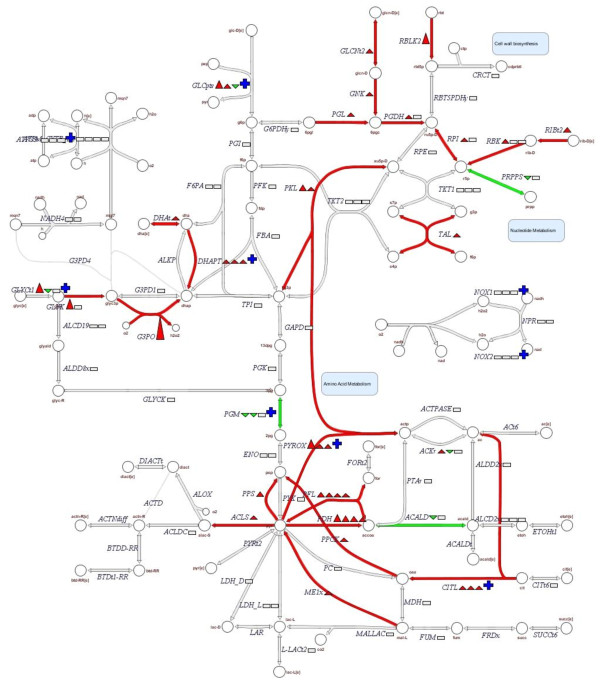
Primary metabolic pathway of L. plantarum NZ3410 (ΔctsR) compared to L. plantarum WCFS1 grown at 40°C. Green lines or triangles indicate downregulation, whereas red lines or triangles indicate upregulation, open rectangles indicate no change, and plus symbols indicate that expression of more than 3 genes is acquired for enzyme production. Abbreviations are addressed in the Additional file 3: Table S2, according to Teusink et al. [28].